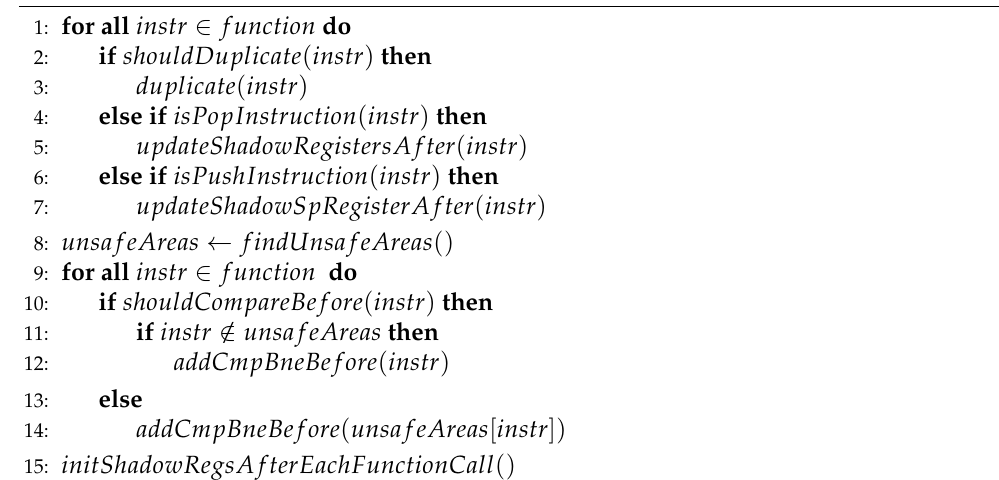
Algorithm 1 implementDupComp function of